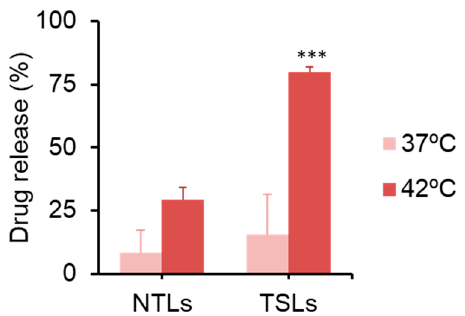
Figure 5. Drug release test. The release of [ 125 I] 5 from NTLs and TSLs was analyzed in 90% FBS at 37 ◦ C for 1 h or 42 ◦ C for 10 min. Data are presented as mean ± SD for three samples. *** p < 0.001 vs. other conditions.